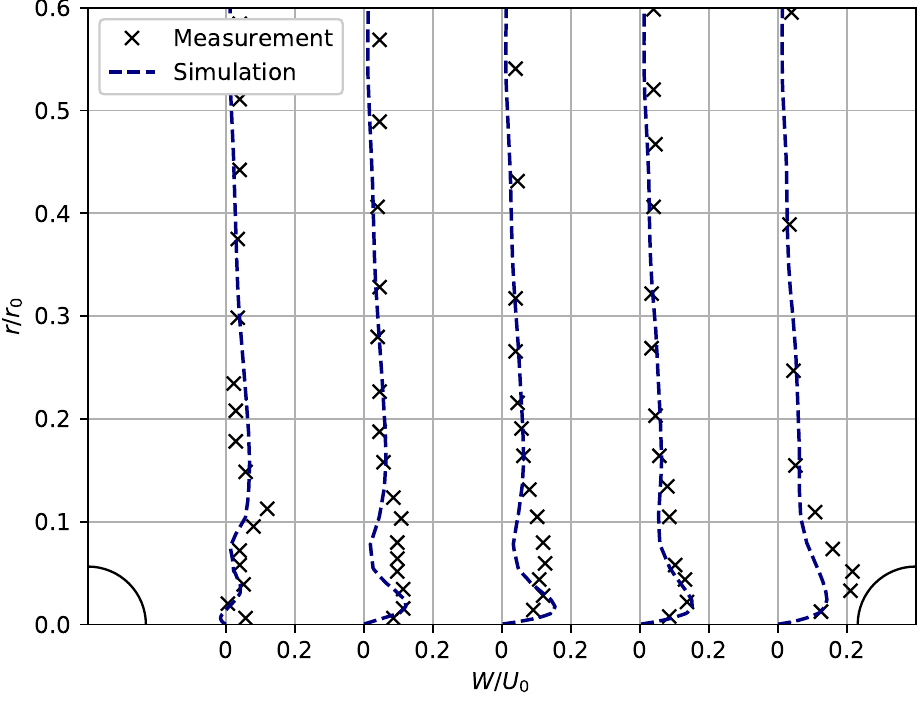
Figure 6. Comparison between measurement and simulation with the velocity in the circumferential di-